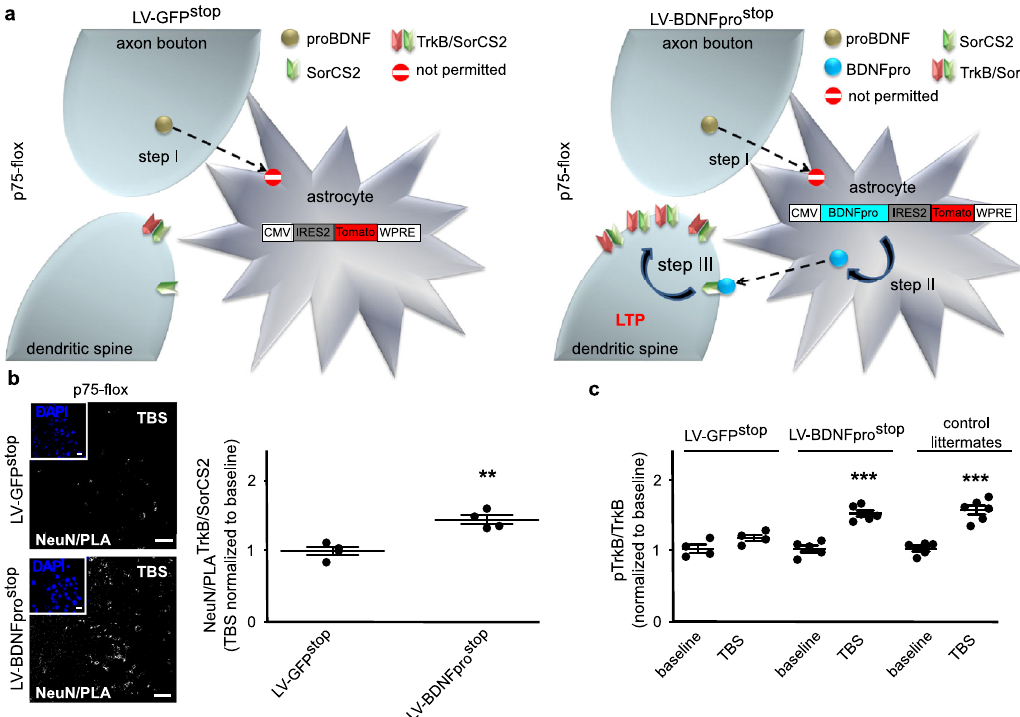
Fig. 7 BDNFpro-induced TrkB/SorCS2 targeting. a Schematic representation of the experimental design. Step I, deletion of p75 NTR in astrocytes from tamoxifen-treated p75- fl ox mice precludes proBDNF transfer from neurons to astrocyte following TBS. Step II, LV-BDNFpro stop transduction replaces BDNFpro in astrocytes. Step III, astrocytic BDNFpro provides fi nal increase of TrkB/SorCS2 complexes in dendritic spines and LTP maintenance. b z-stack reconstruction showing NeuN/PLA TrkB/SorCS2 colocalization signal in TBS-slices from p75- fl ox mice transduced with LV-GFP stop or LV-BDNFpro stop . Scale bars: 40 μ m. The insets show the fi eld of analysis. Scale bars: 15 μ m. NeuN/PLA TrkB/SorCS2 colocalization was quanti fi ed using Mander ’ s overlap. ** p < 0.01 (unpaired t -test) ( n = 4 slices, 3 mice for each experimental condition). c Dot plot shows quanti fi cation of pTrkB/TrkB colocalization in baseline- and TBS- slices from p75- fl ox mice transduced with LV-GFP stop or LV-BDNFpro stop and control littermates using Mander ’ s overlap. *** p < 0.001 (unpaired t -test) ( n = 4 slices, 3 mice for p75- fl ox mice/LV-GFP stop /TBS; n = 4 slices, 3 mice for p75- fl ox mice/LV-GFP stop /baseline; n = 6 slices, 4 mice for p75- fl ox mice/ LV-BDNFpro stop /TBS; n = 5 slices, 4 mice for p75- fl ox mice/LV-BDNFpro stop /baseline; n = 5 slices, 3 mice for control littermates/TBS; n = 6 slices, 3 mice for control littermates/baseline). Data are normalized to baseline and presented as mean ±